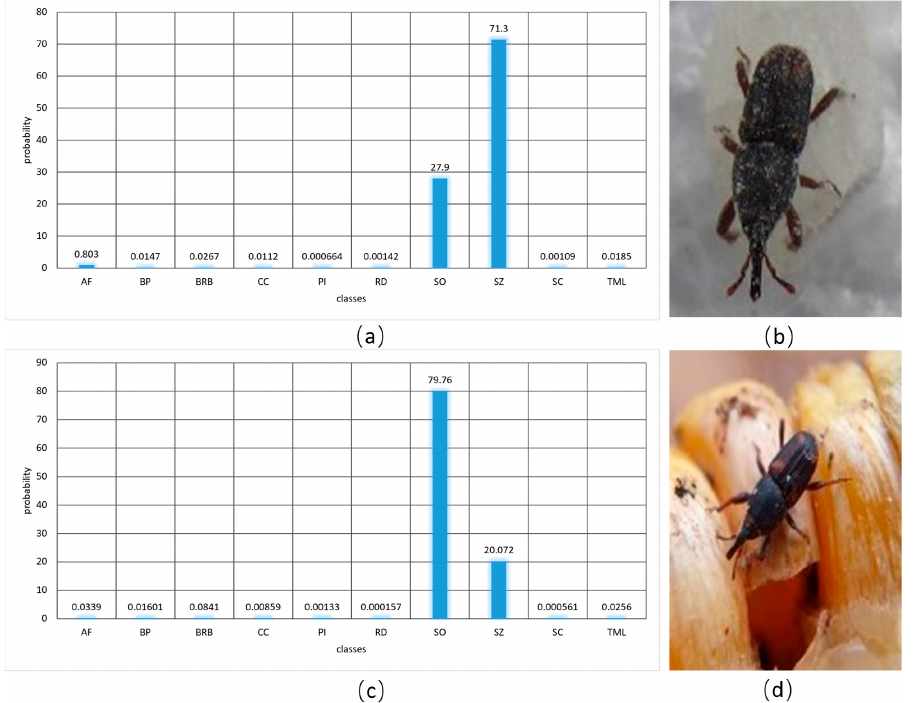
phology of SO and SZ, there are two prediction probabilities much bigger than the other